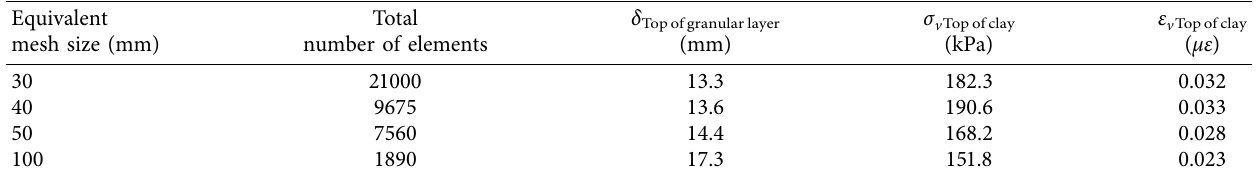
Table 1: Summary of mesh convergence results.